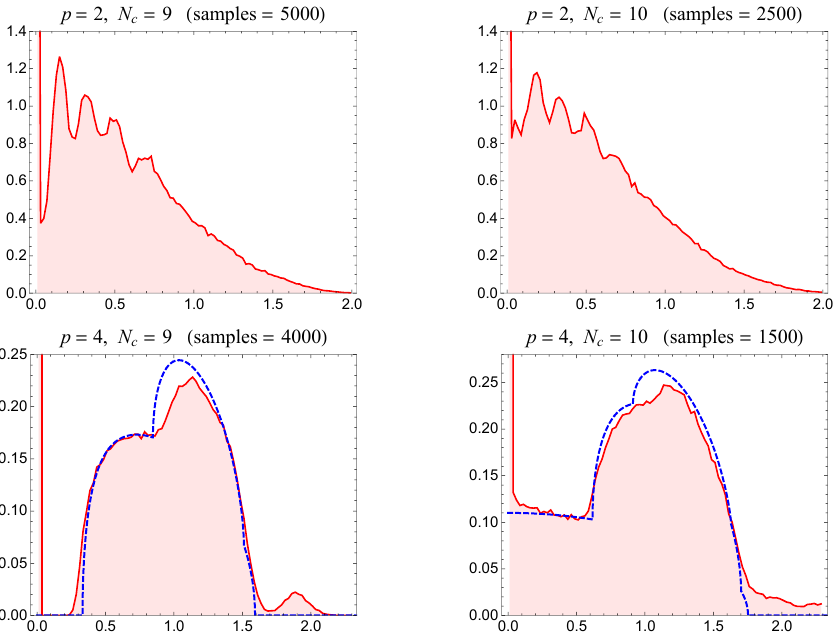
Figure 6 . Spectral density of M in (5.1) for p = 2 (top) and 4 (bottom) at N c = 9 and 10, averaged over many random samples. Since the spectra are symmetric about 0, only the nonnegative part is shown. The sharp peak at the origin in each plot represents the density of exact zero modes. In all plots J = 1 and the total density is normalized to 1. The blue dashed lines in the bottom plots are analytic approximations (5.9) based on the Mar(cid:20)cenko-Pastur